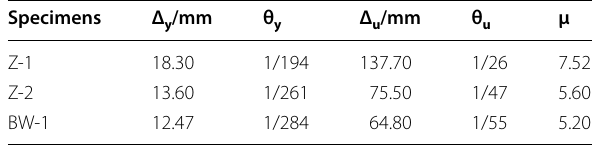
Table 6 Displacement and ductility factor of